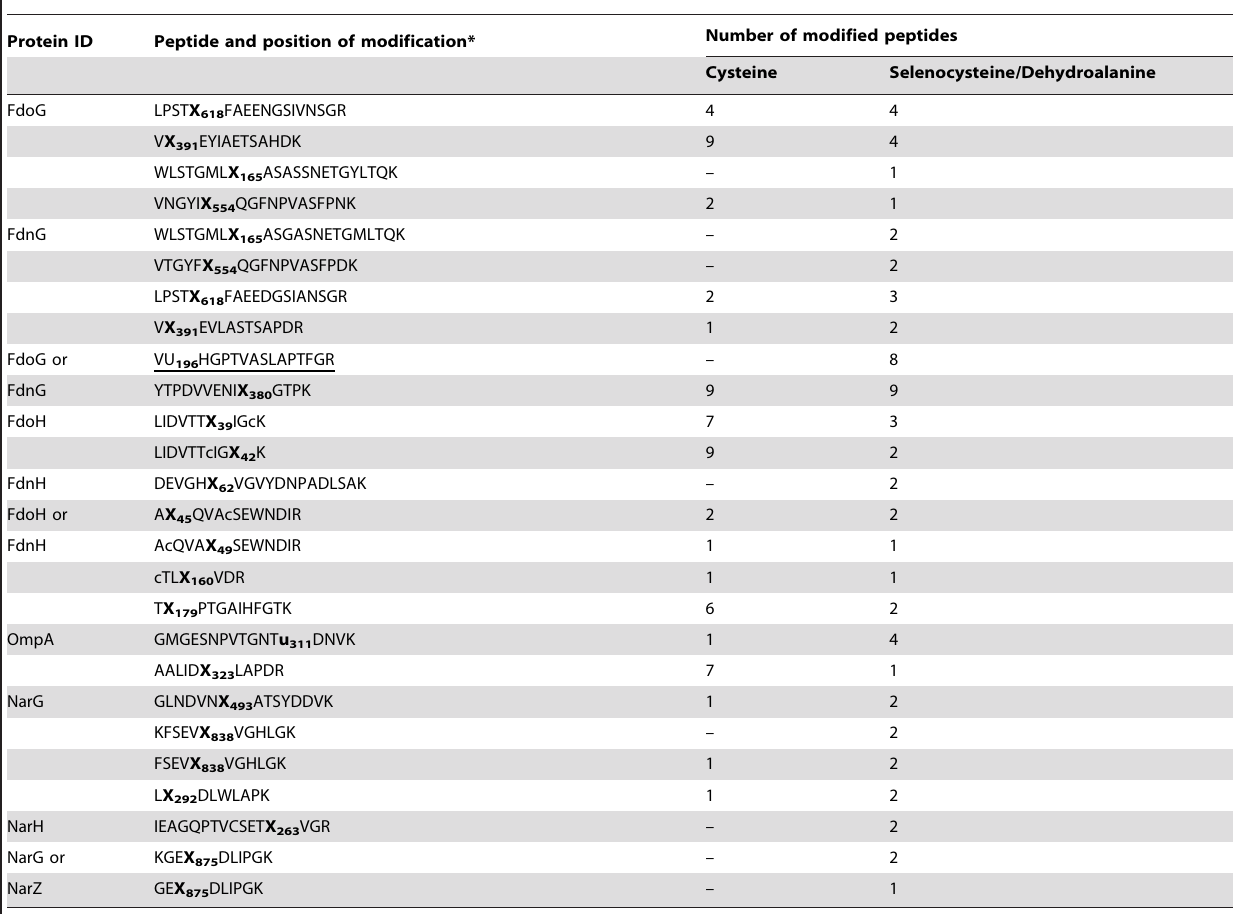
Table 3. Overview of peptides containing cysteines, selenocysteines, and dehydroalanines at specific positions*.